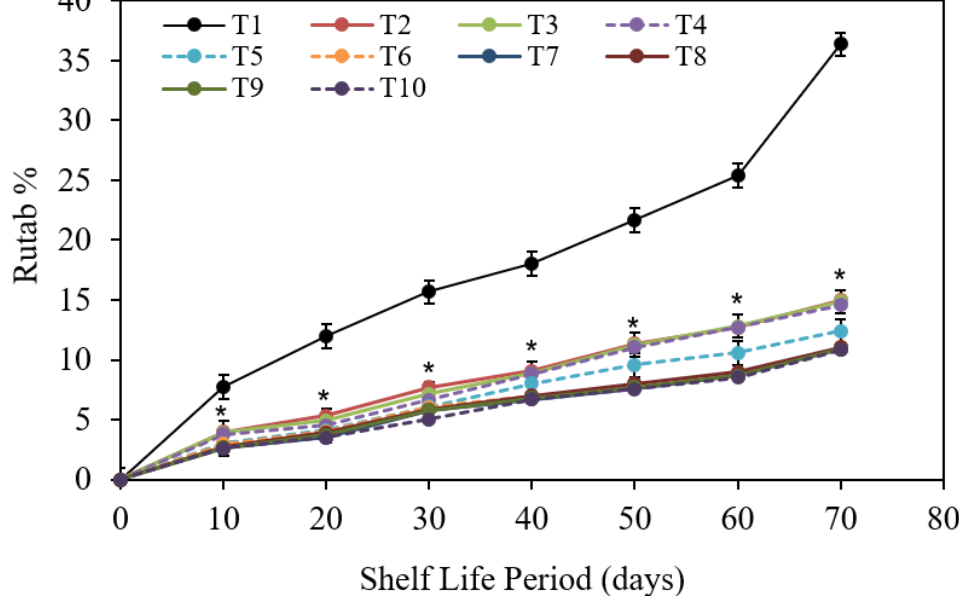
Figure 7. The impact of pre-harvest chitosan, chitosan nanoparticle, and CaCl 2 foliar spray treatments on rutab proportion of Barhi date fruits under cold storage for 70 days. Note that * sign denotes the significant differences between the control and edible coatings treatments, and T1, T2, T3, T4, T5, T6, T7, T8, T9, and T10 are water (control), 1 g/L chitosan, 2 g/L chitosan, 3 g/L chitosan, 1 g/L chitosan nanoparticles, 2 g/L chitosan nanoparticles, 3 g/L chitosan nanoparticles treatments, respectively.